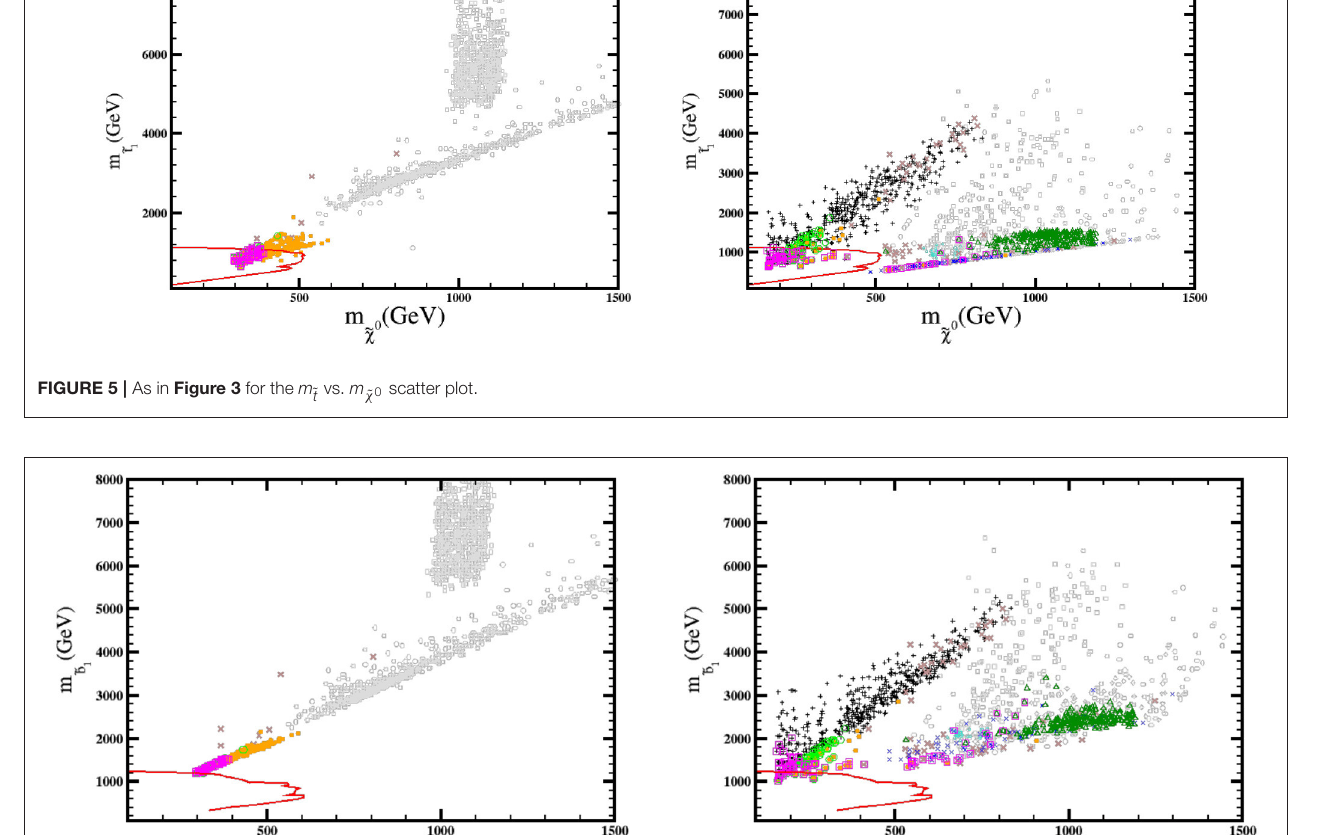
FIGURE 6 | As in Figure 3 for the m